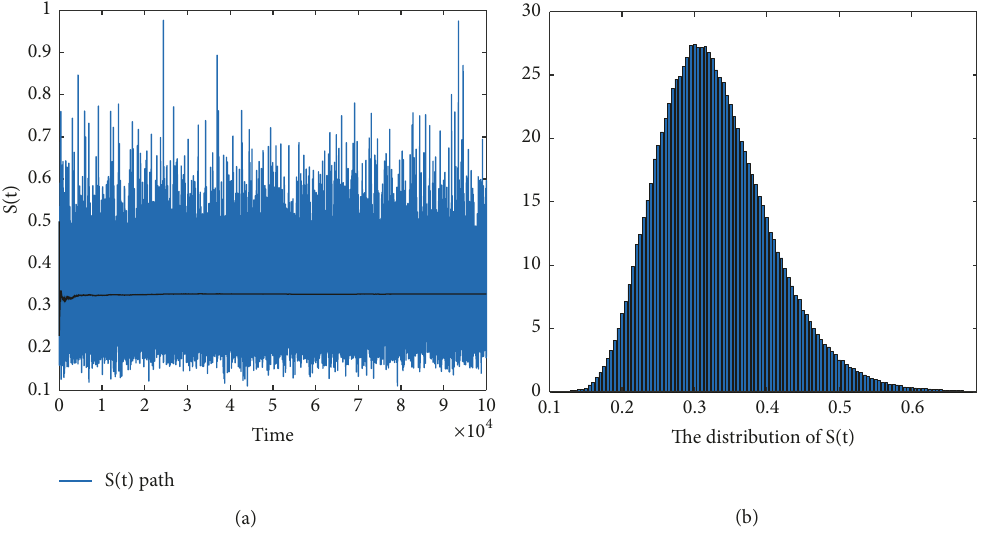
Figure 3: (a) is the time series of 𝑆(𝑡) with initial value 𝑆(0) = 0.5 ; (b) is the distribution interval of 𝑆(𝑡) .